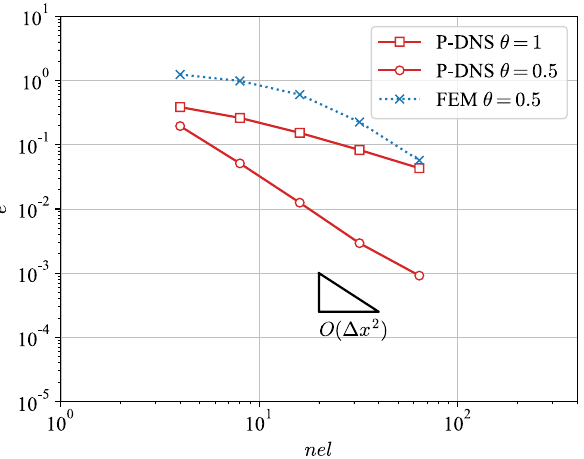
Fig. 12 A transient advective–diffusive–reactive problem. Convergence of the error of P-DNS and FEM solutions when keeping fixed CFL=0.25